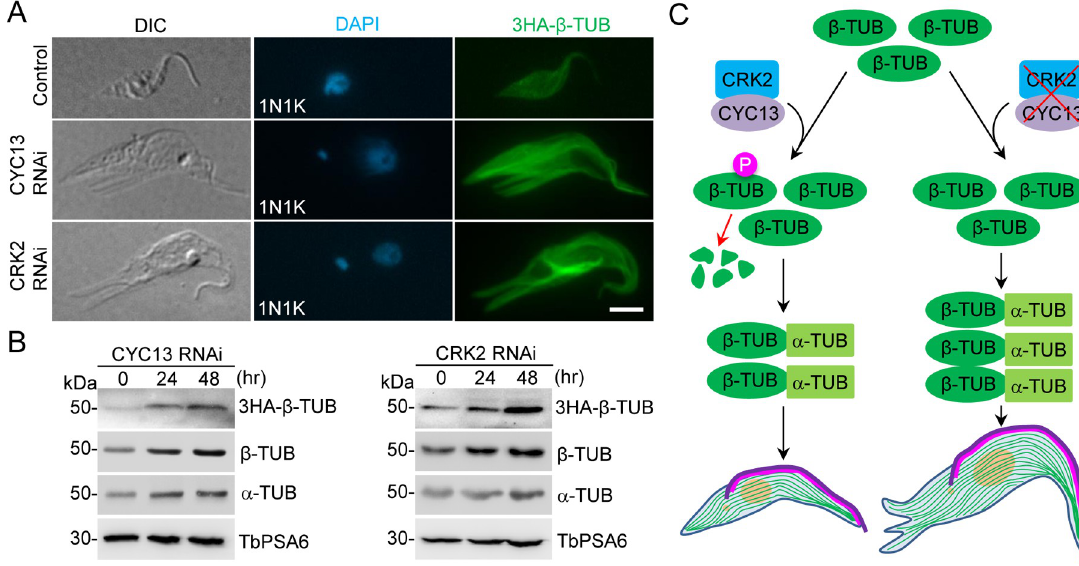
Fig 8. Knockdown of CYC13 or CRK2 causes an increase of cellular β -tubulin levels. ( A ). Immunofluorescence microscopic analysis of β -tubulin in the detergent-extracted cytoskeleton of non-induced control cells, CYC13 RNAi cells, and CRK2 RNAi cells. β -tubulin was endogenously tagged with an N-terminal triple HA epitope and detected by FITC-conjugated anti-HA antibody. Scale bar: 5 μ m. ( B ). Western blotting to detect levels of 3HA- β -tubulin, β -tubulin, and α -tubulin in non-induced control cells, CYC13 RNAi cells, and CRK2 RNAi cells. An equal amount of total proteins for each time point was loaded into each well. 3HA- β -tubulin was detected by anti- HA antibody, β -tubulin was detected by KMX-1 antibody, and α -tubulin was detected by anti- α -tubulin antibody. TbPSA6 served as a loading control. ( C ). Model of CRK2-mediated phosphorylation of β -tubulin on its stability, microtubule dynamics, and cytoskeleton morphology in T . brucei . Green, subpellicular microtubule array; Pink, FAZ-associated microtubule quartet; Purple, flagellar axoneme.